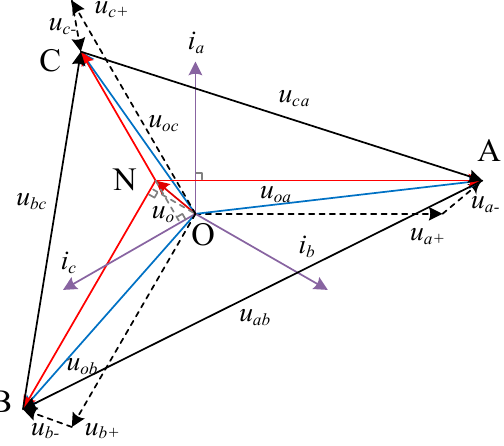
Figure 2. Phasor diagram of the star-connected SVG.